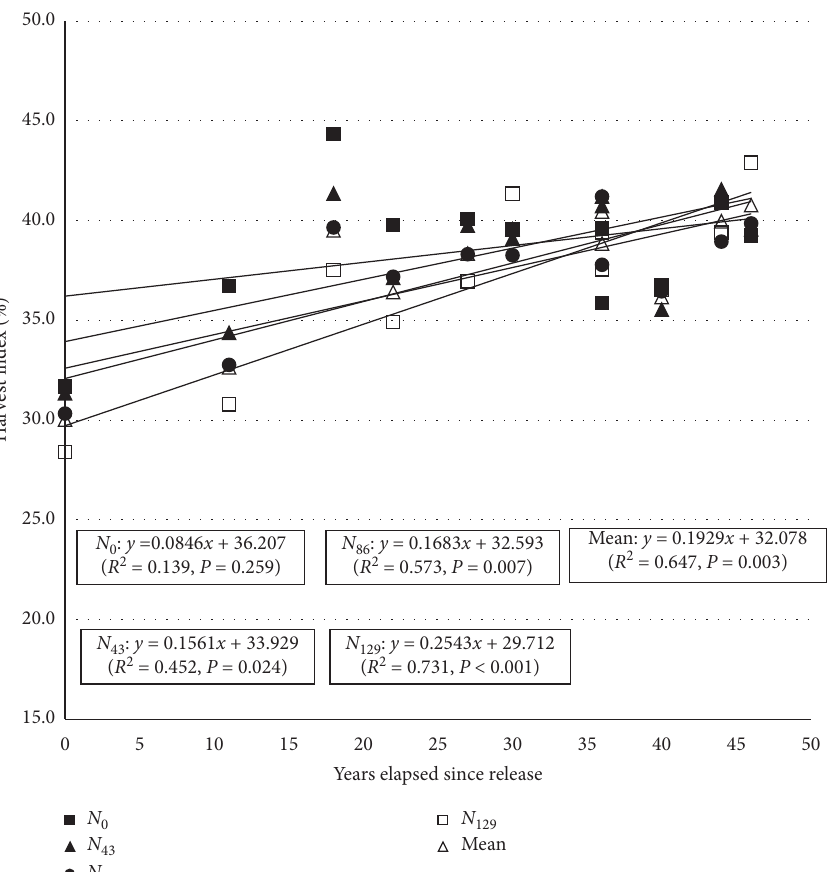
Figure 3: Relationship of harvest index (%) of 11 bread wheat cultivars released between 1960 and 2006 and grown at four N levels with the time elapsed since their year of